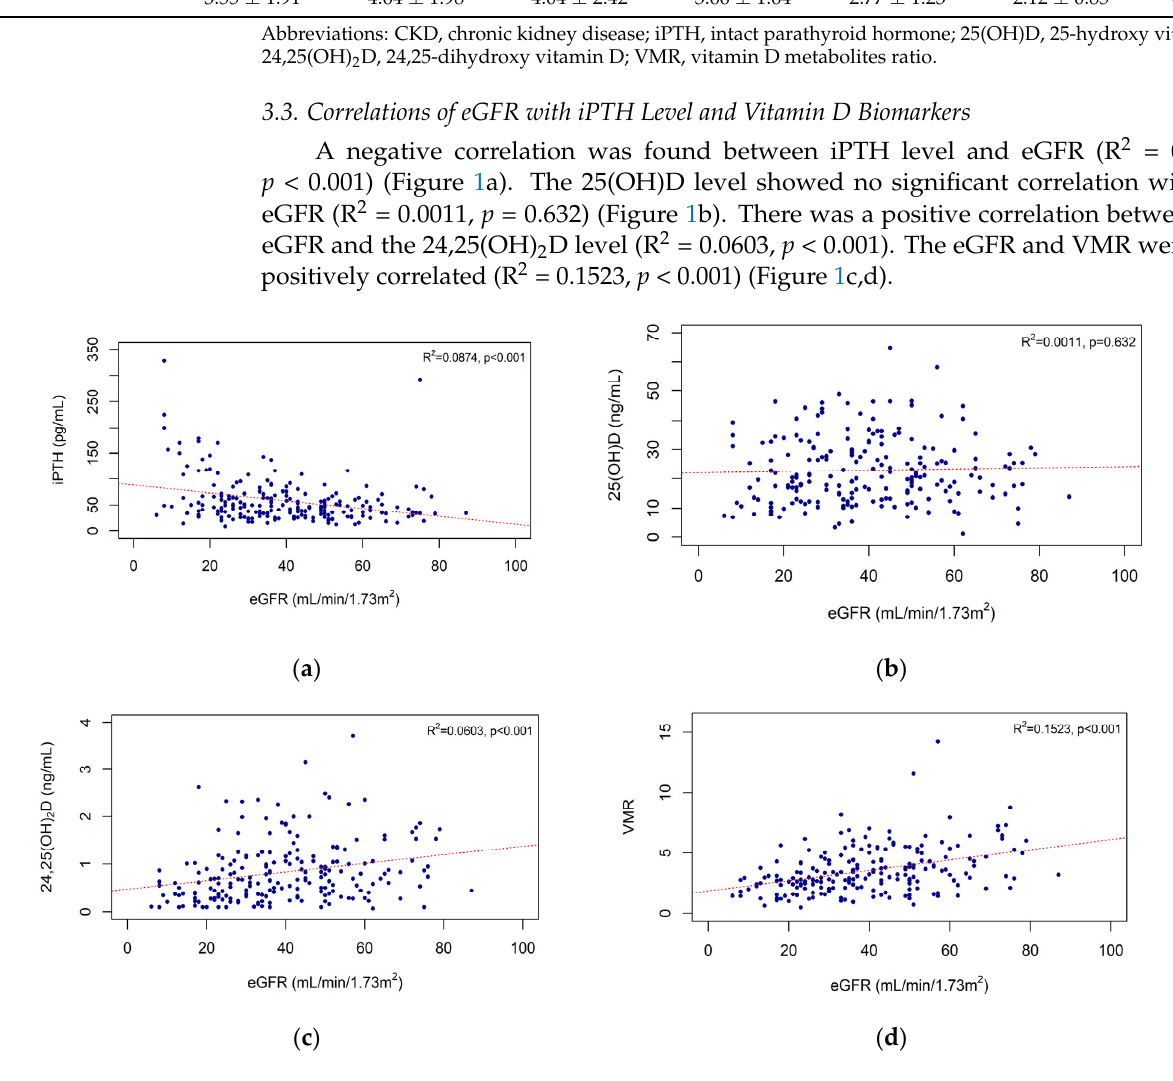
Figure 1. Correlations of eGFR with iPTH and vitamin D biomarkers: eGFR and iPTH ( a ), eGFR and 25(OH)D ( b ), eGFR and 24,25(OH) 2 D ( c ), and eGFR and VMR ( d ). Abbreviations: eGFR, estimated glomerular filtration rate; iPTH, intact parathyroid hormone; VMR, vitamin D metabolites ratio; 25(OH)D, 25-hydroxy vitamin D; 24,25(OH) 2 D, 24,25-dihydroxy vitamin D.